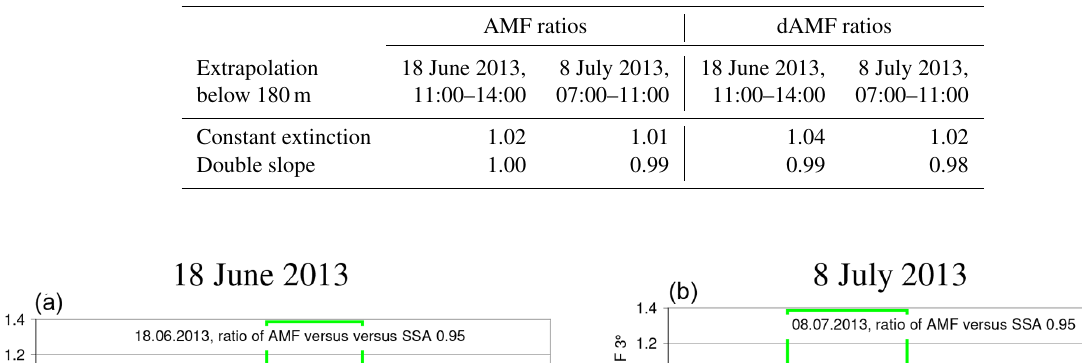
Table A6. Average ratios of O 4 (d)AMFs simulated for aerosol extinction profiles with different extrapolations below 180m vs. the results for the standard settings (linear extrapolation) for the middle period on each selected day.